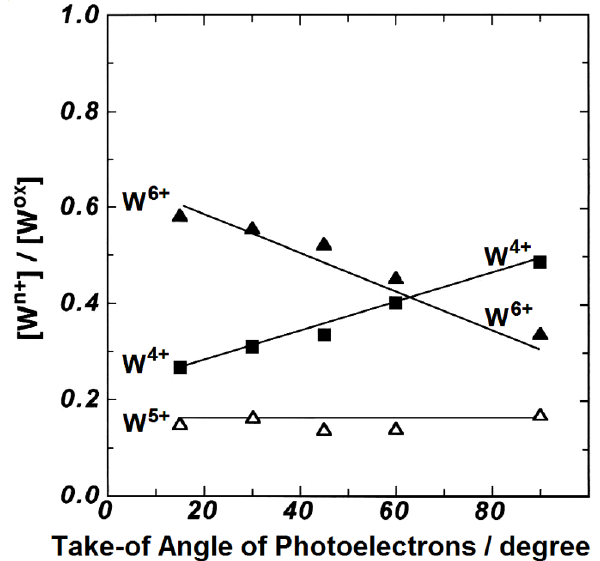
Figure 5: Relative amounts of W 4+ , W 5+ and W 6+ ions in the passive layers of W-26Nb deposit after exposure in 12 M HCl for 5 h at 30 ℃ as a function TOA.